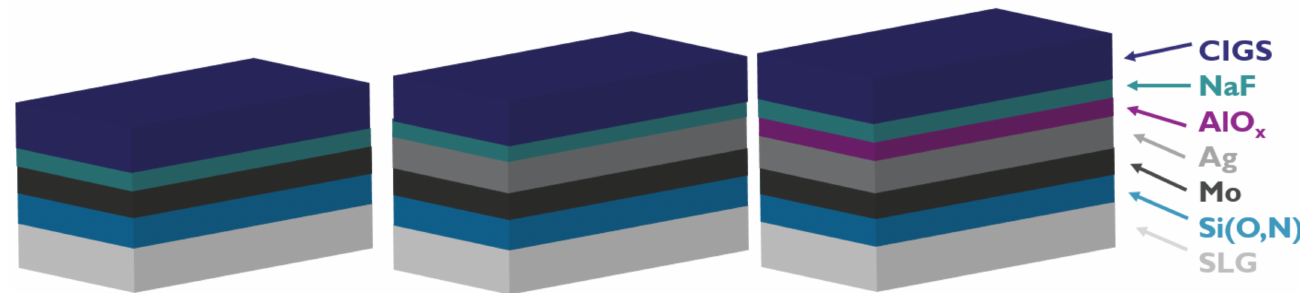
Figure 1. Schematic overview of the different samples: ( left ) standard CIGS layer on Mo; ( middle ) CIGS layer grown on 10 nm Ag; ( right ) CIGS layer grown on Ag/AlO x stack. The AlO x was 3 nm and the Ag layer 10 or 20